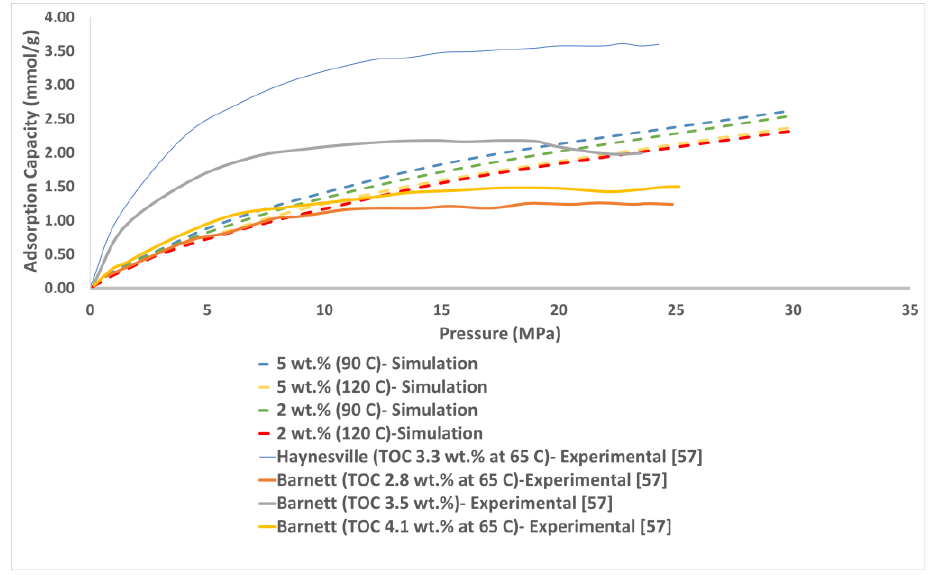
Figure 8. Comparison of the simulated and experimental adsorption isotherms [57] . “ Adapted with permission from Ref. [57] . 2023, Elsevier [License No. 5479231488060] ”.